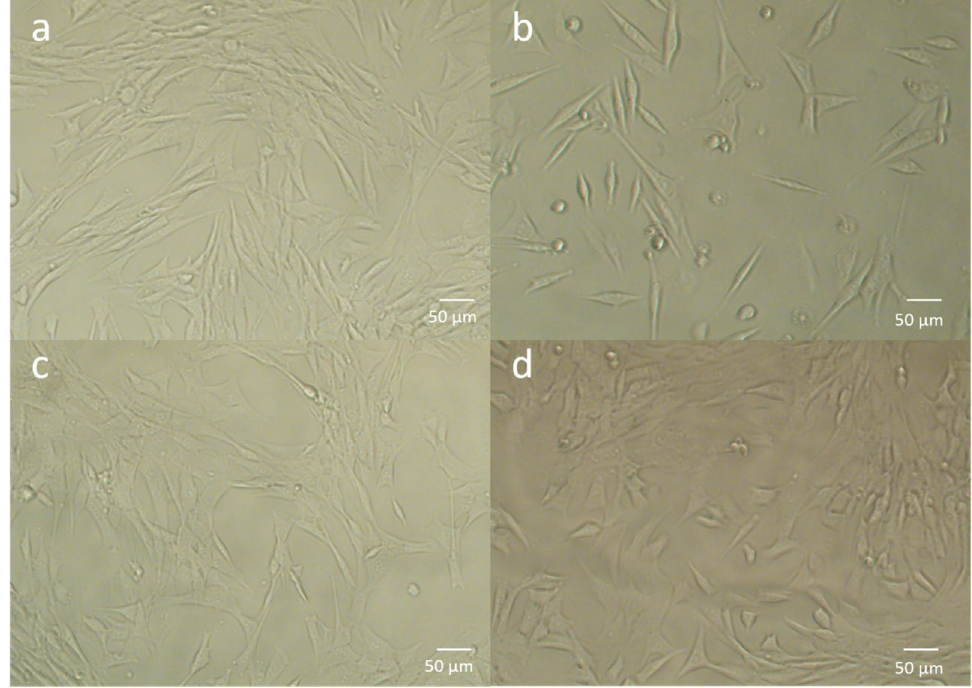
Figure 10. Inverted microscopy images (20×) of the MC3T3-E1 cells cultured with extracts from the ( a ) AZ31, ( b ) MAO + AZ31, ( c ) AHEC + MAO + AZ31 specimens, and ( d ) negative control group after 5 d.